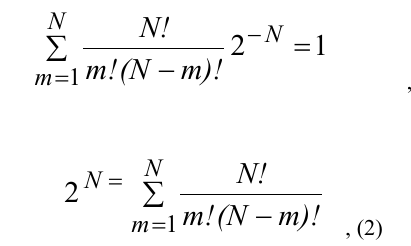
Figure 5. Graphic User Interface Depiction of RSVP